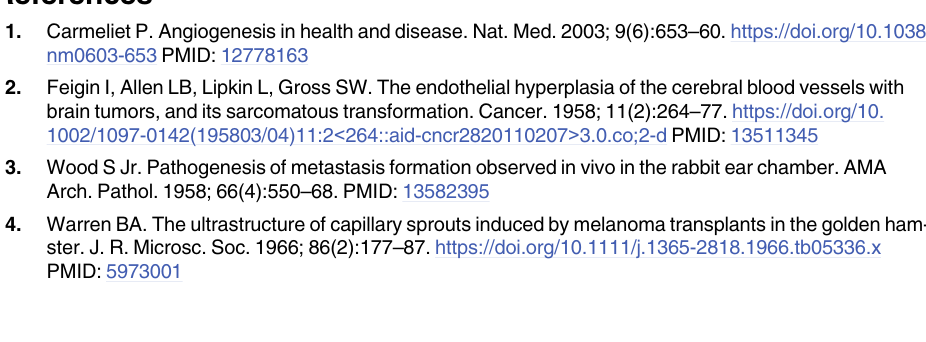
S3 Text. Effects of morphological changes to flow rates at different